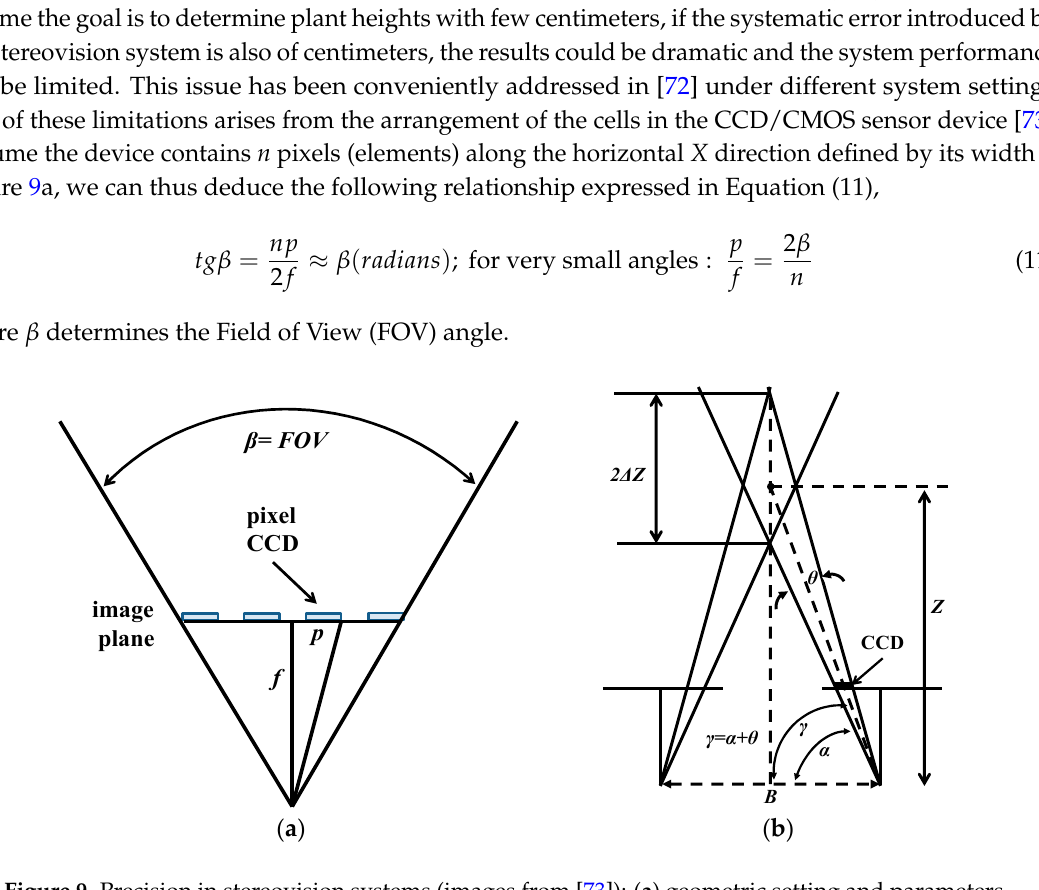
Figure 10. Precision in stereovision systems (images from [73]): ( a ) geometric setting and parameters defined by the CCD; ( b ) geometric relations on triangles from the 3D mapping.